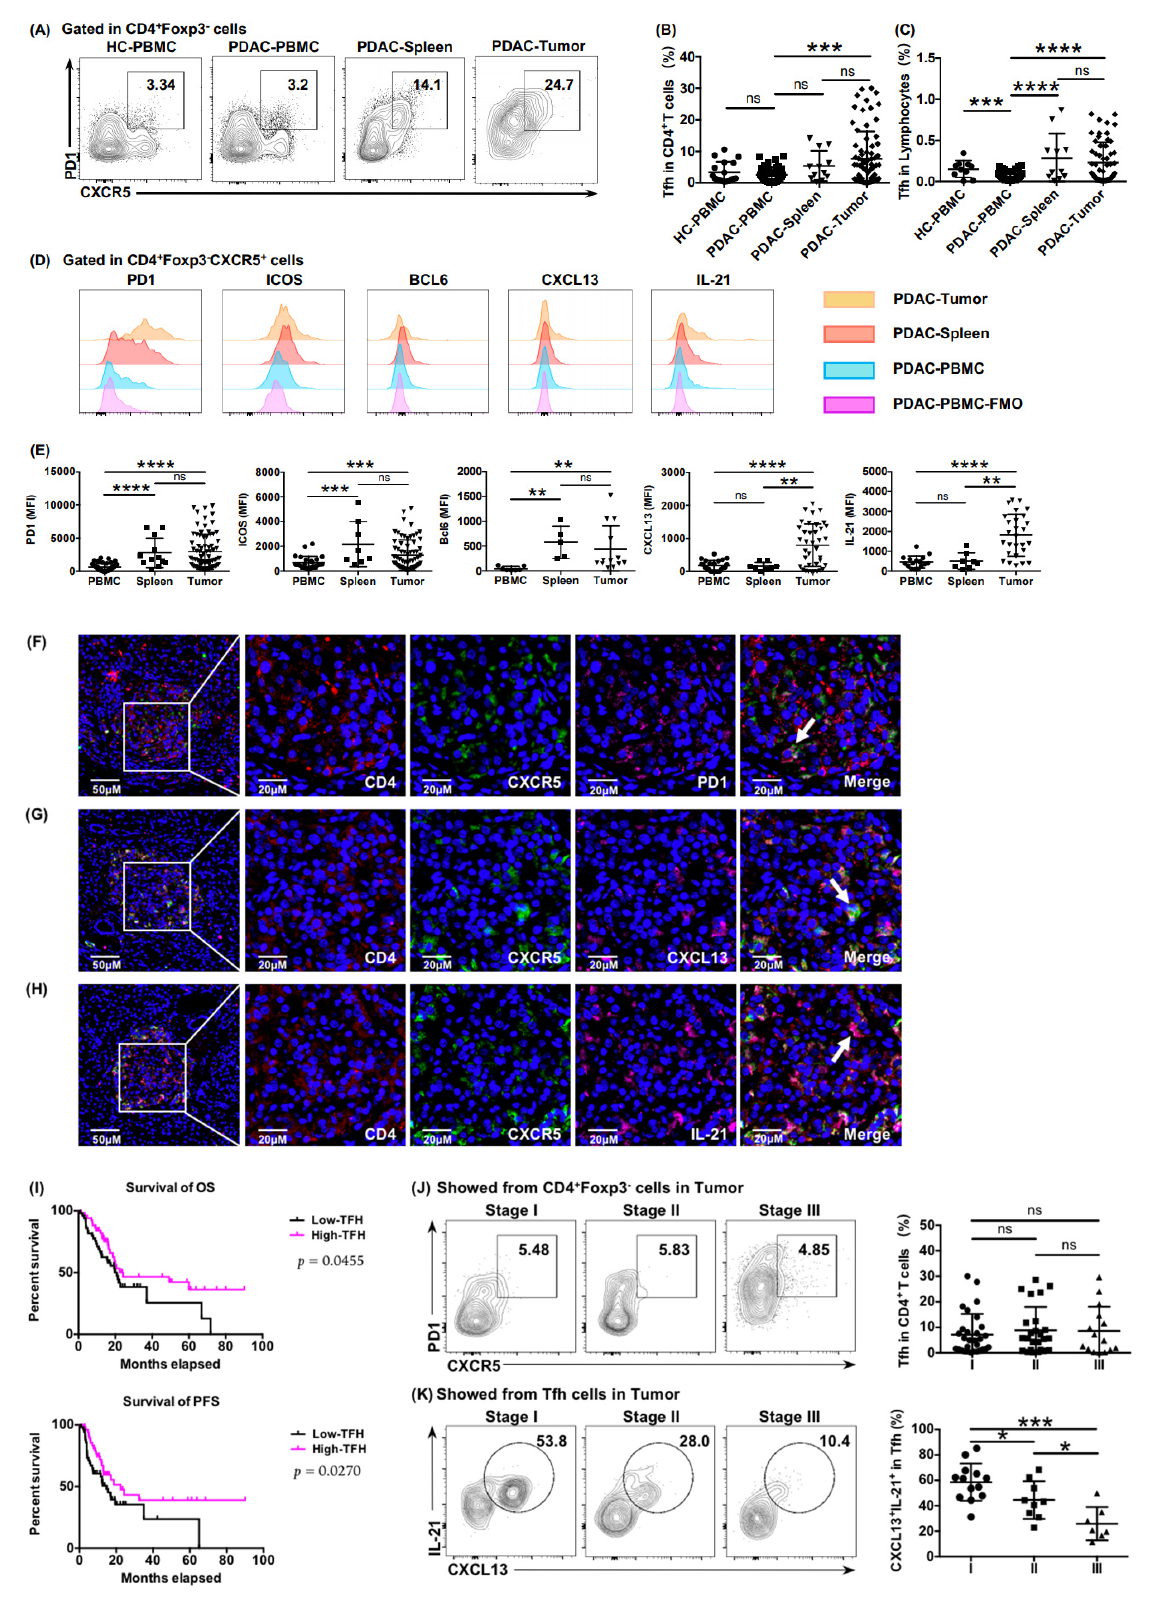
Figure 1. Tumor-infiltrating Tfh cells correlated positively with the prognosis of patients with PDAC. ( A ) Plots showing representative CXCR5 and PD1 surface staining of Tfh cells from peripheral blood (healthy donors and patients with